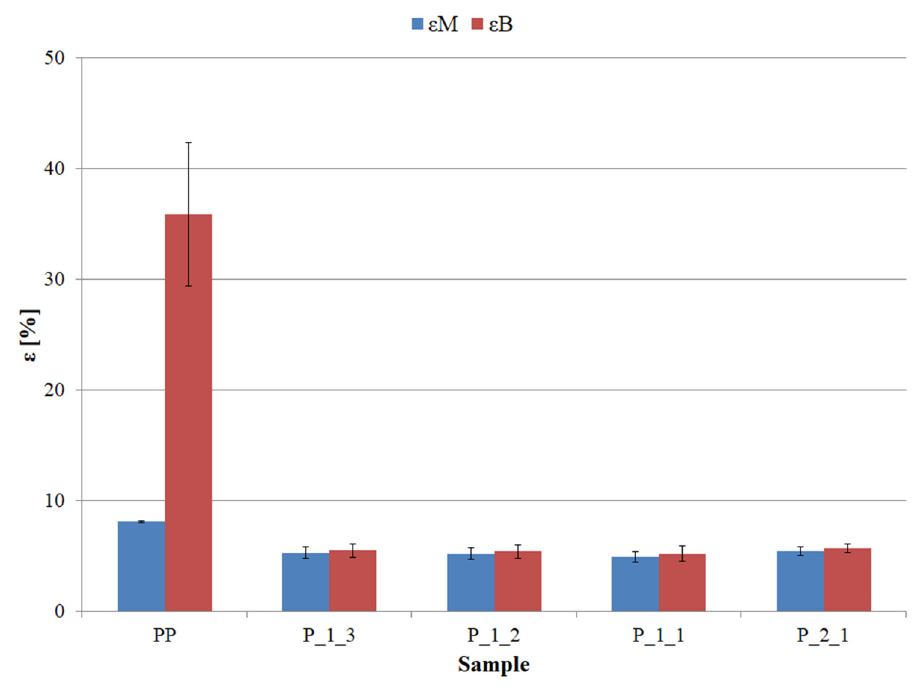
Figure 5. Elongation at maximum stress ( ε M ) and elongation at break ( ε B ) of individual samples.